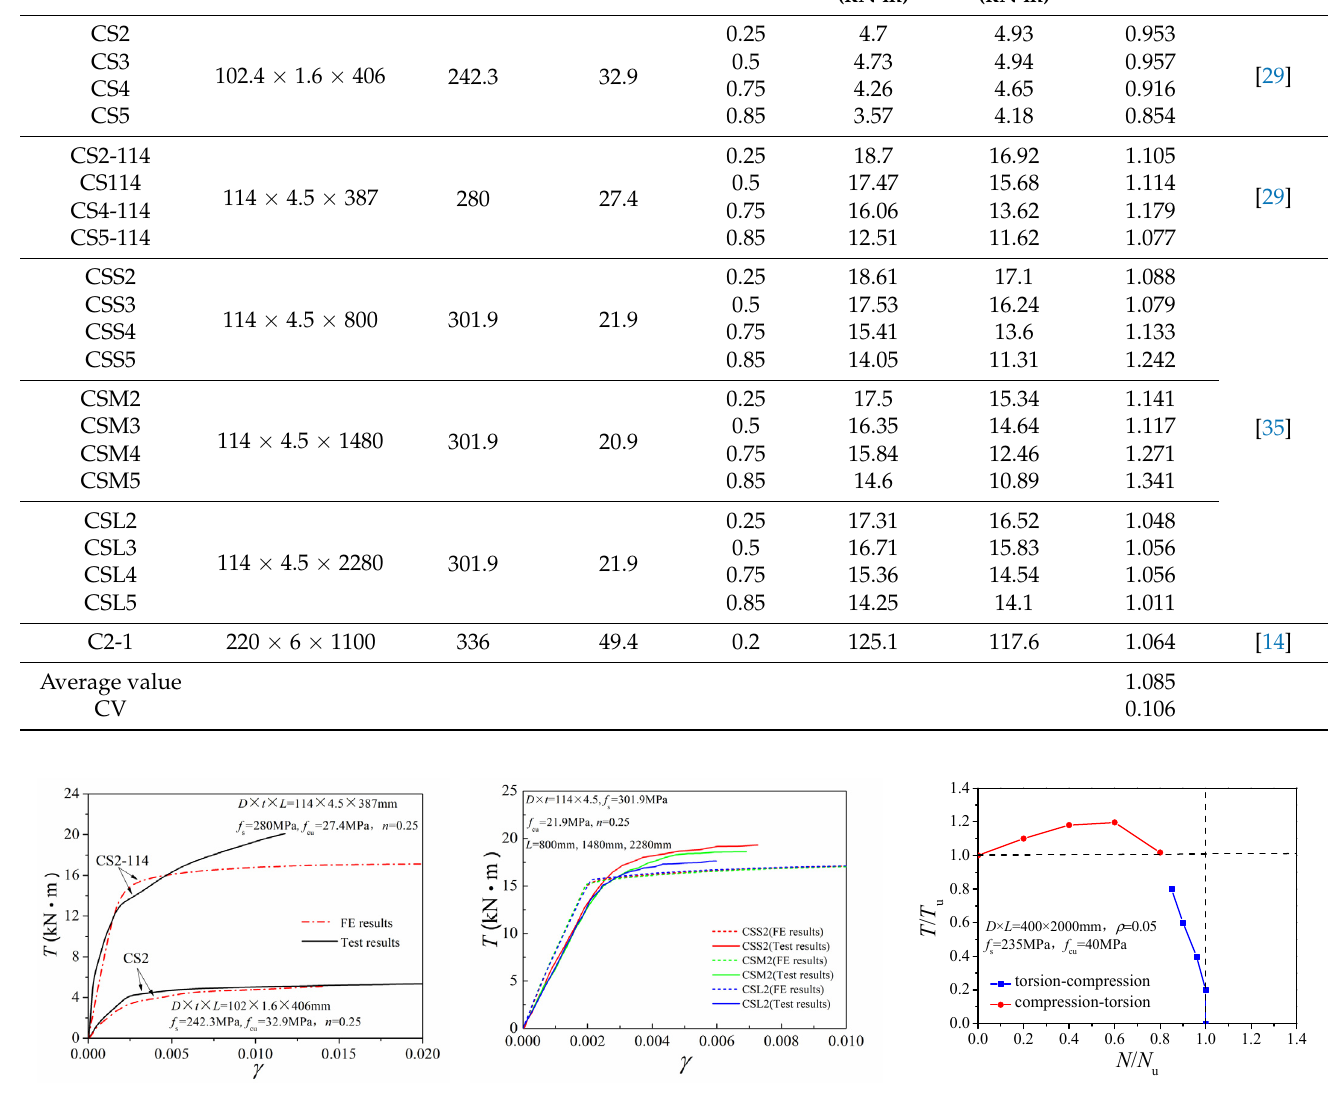
Table 1. Comparison between the test and FE results.